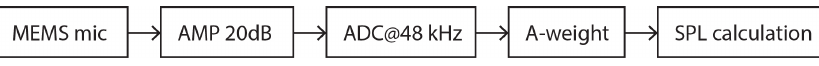
Figure 7. Block diagram of sensor’s SPL